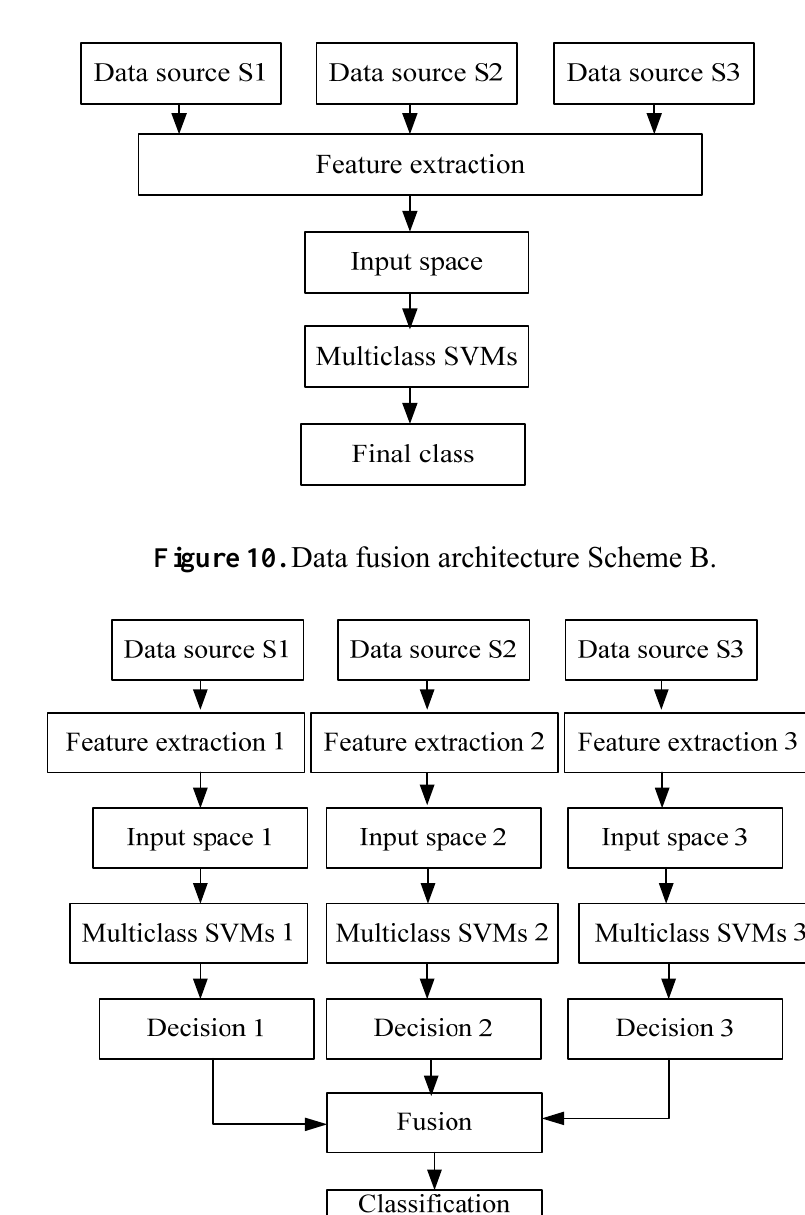
Figure 9. Data fusion architecture Scheme A.